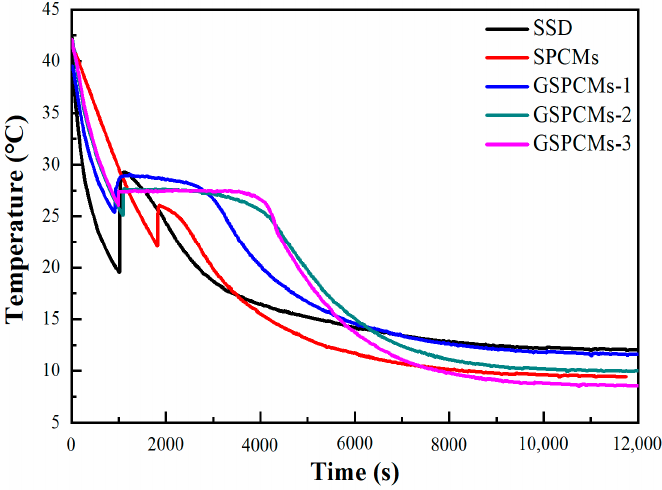
Figure 4. Step cooling curves of the pure Na 2 SO 4 ·10H 2 O, S-PCMs and GS-PCMs.